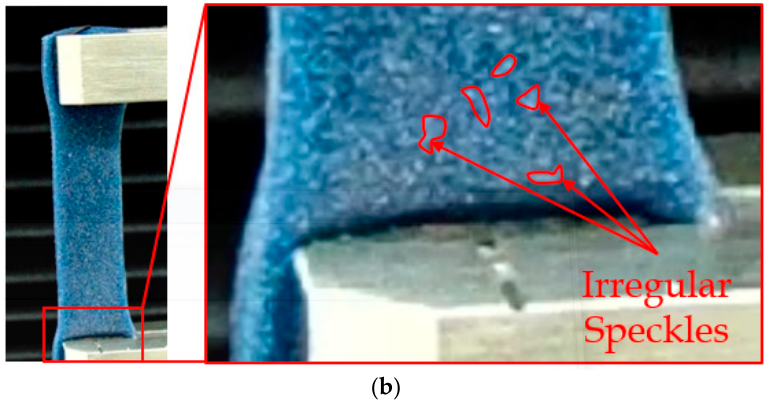
Figure 2. ( a ) Biofidelic human skin phantoms with wounds. AR is the aspect ratio in each case; ( b ) Irregular speckle pattern used for Digital Image Correlation (DIC). ( b ) Irregular speckle pattern used for Digital Image Correlation